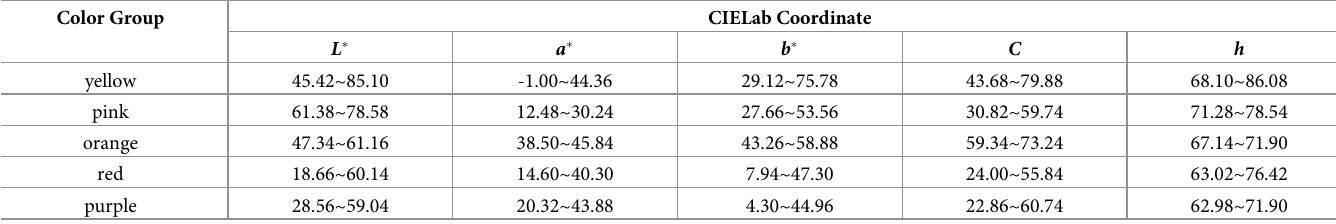
Table 3. The distribution range of CIELab measuring from the limb of petals for Hemerocallis . Color